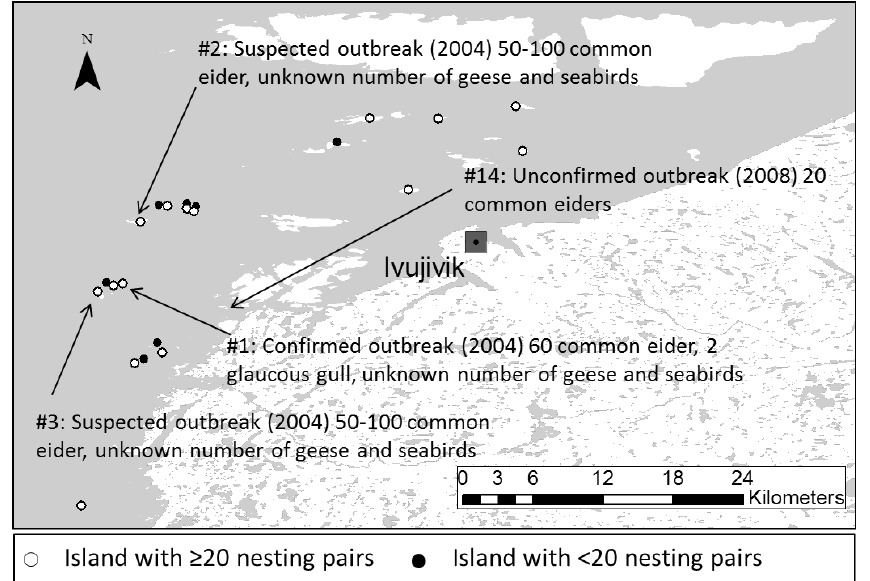
Figure A1.6. Survey zone 6: Digges